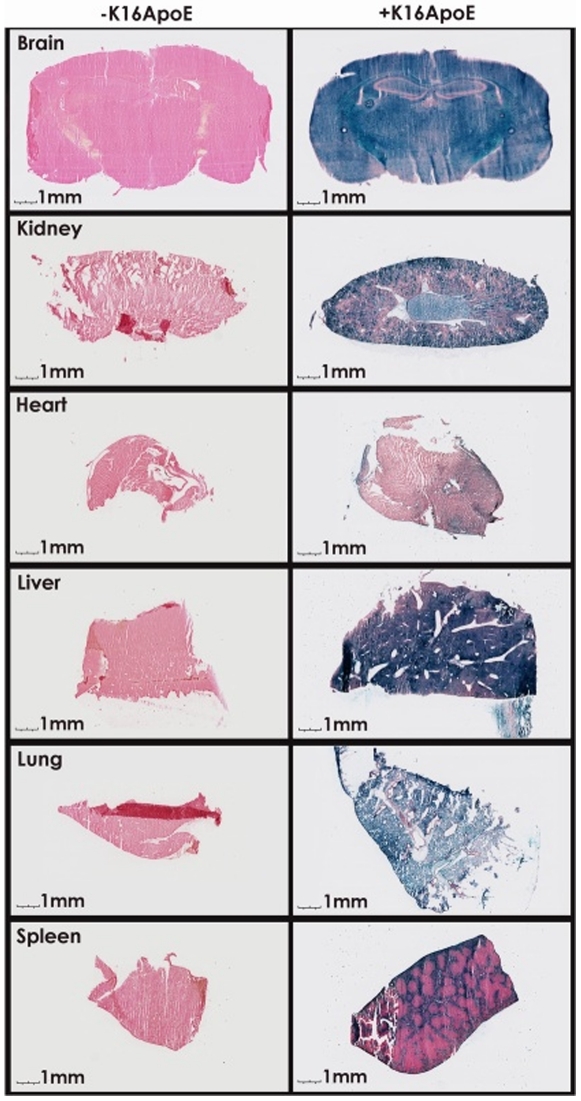
K16ApoE-mediated delivery of beta-galactosidase in various organs.Slides of 25 micron thickness were made with tissues from different organs and stained for beta-galactosidase activity after delivery. Left panel – no K16ApoE; right panel – with K16ApoE.